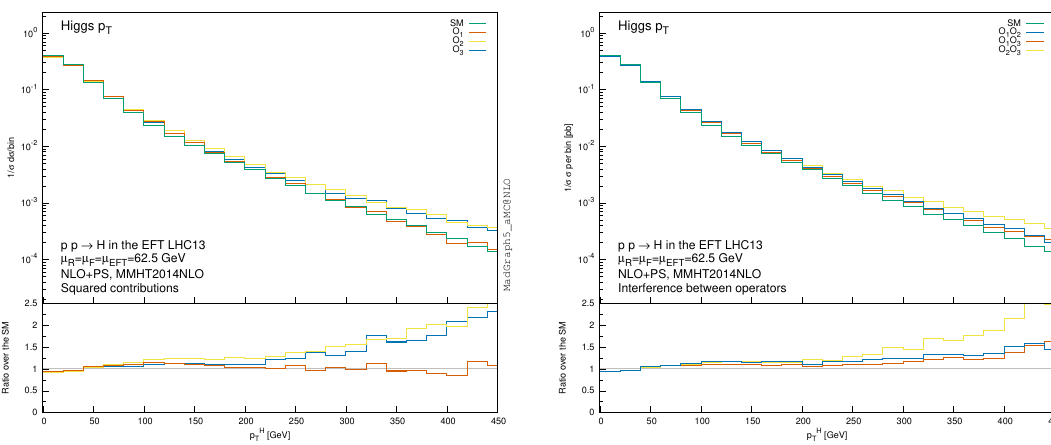
Figure 5 . Higgs transverse momentum distributions, normalised. Left: squared contributions (cid:27) ii . Right: interference between operators, (cid:27) ij . SM contributions and operator contributions are displayed. Lower panels give the ratio over the SM.